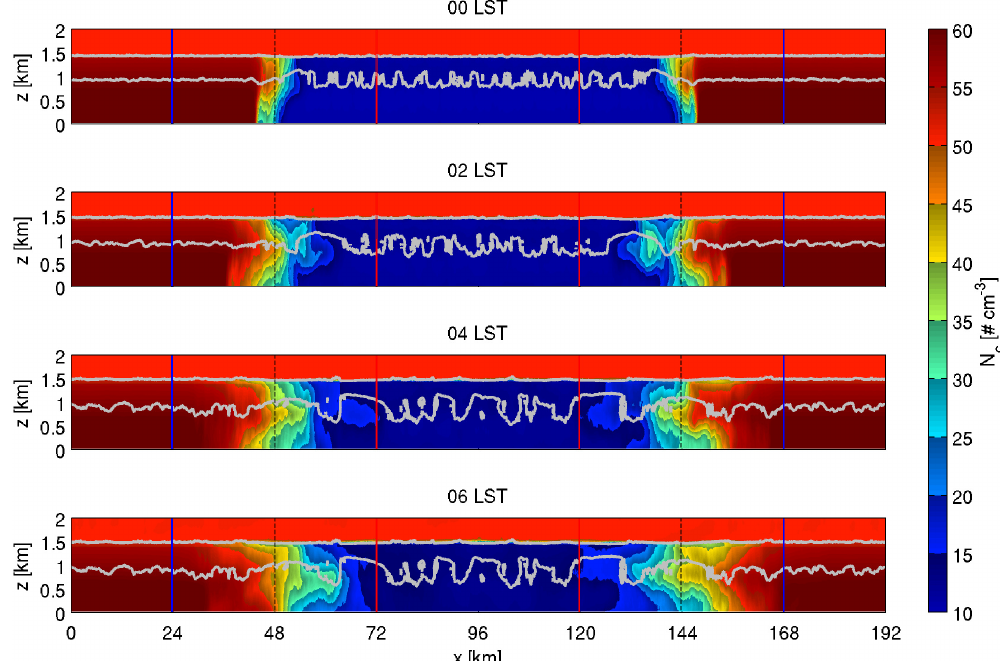
Fig. 5. Snapshots of y -averaged cross-sections of N c from the NCADVECT run with the 0.01gkg − 1 contour of y -averaged q c , demonstrating the diffusion of the microphysical gradient by boundary layer turbulence and resulting cloud structure.